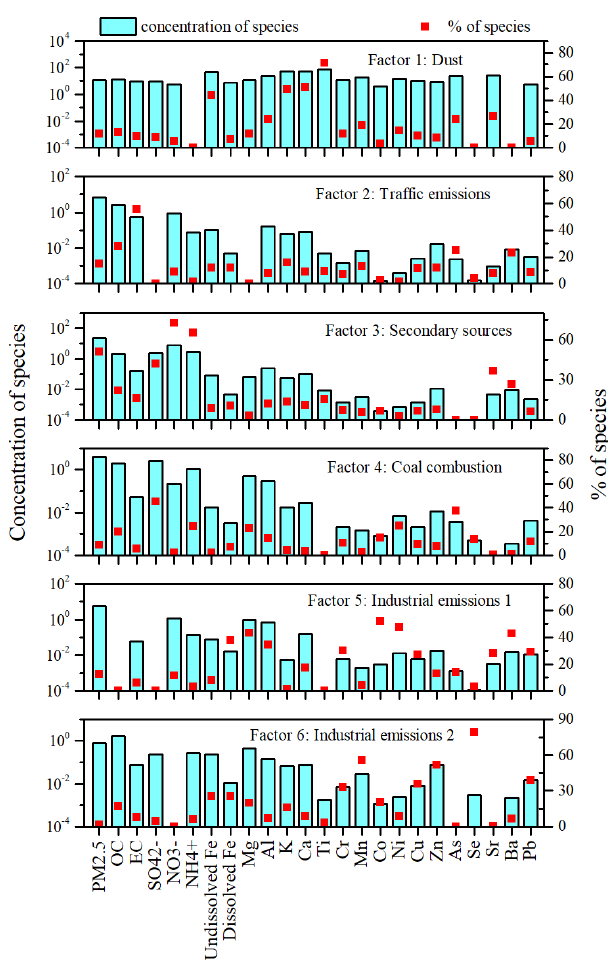
Figure 2. Factor profiles deduced from the PMF model